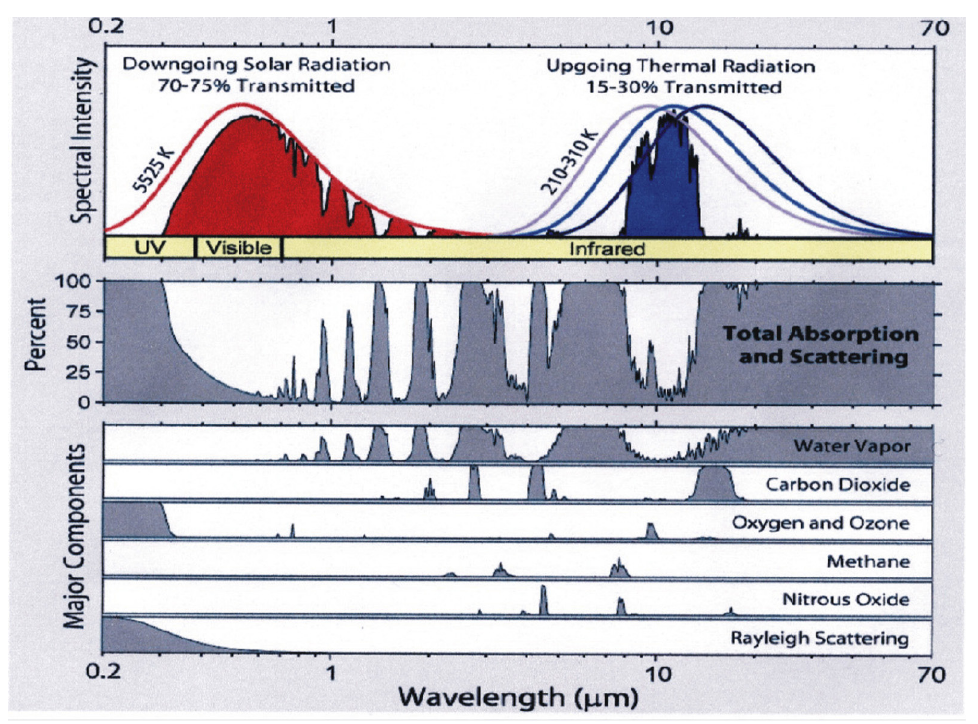
Fig. 7. – Radiation transmitted by the